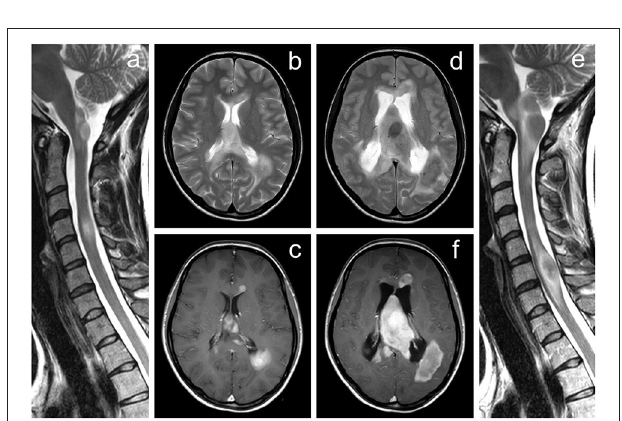
FIGURE 2 | MRI of the brain and cervical spine documenting a significant progression of the tumefactive lesions. (a–c) Examination performed ∼ 5 years after the initial diagnosis of multiple sclerosis, (d–f) follow-up examination after further 22 months. Several tumor-like enhancing lesions located around the lateral ventricles are visible on axial T2-weighted images (b,d) and contrast-enhanced axial T1-weighted images (c,f) . Extensive mass lesion located within the septum pellucidum finally caused the hydrocephalus by obstruction of the interventricular foramina; a significant dilatation of the lateral ventricles is seen on follow-up examination (d,f) . The progressive course of the disease is also demonstrated by T2-weighted images of the cervical spine in the sagittal plane (a,e)